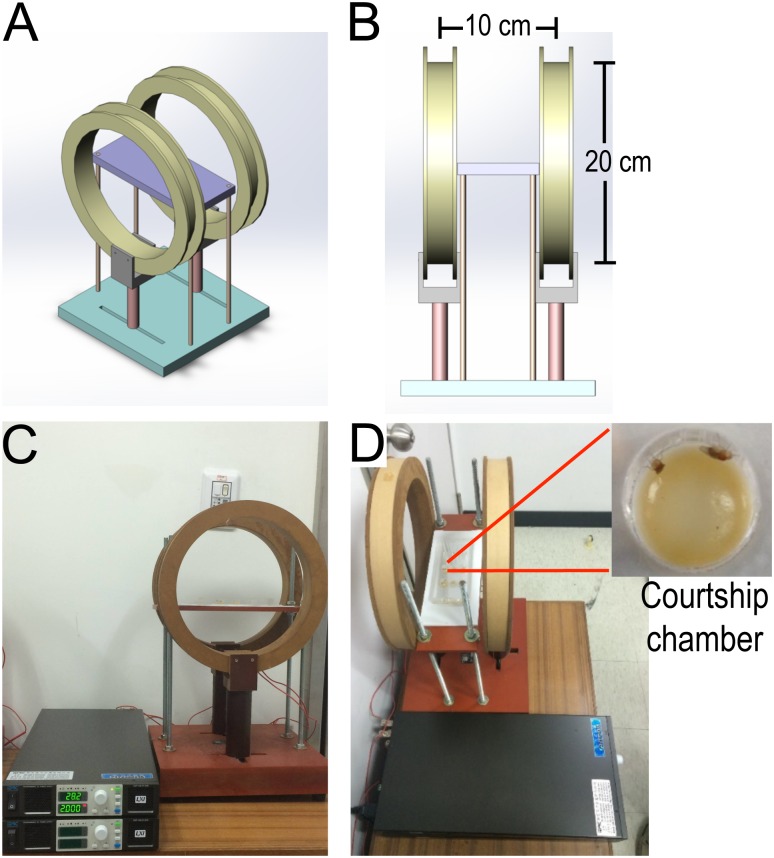
Fly courtship behavioral assay on a Helmholtz coil platform.(A-B) Diagrams of the Helmholtz coil platform. (C) Photograph of the Helmholtz coil platform, which is composed of two Helmholtz coil rings and a DC power supply. (D) The courtship chambers were placed in the middle of the Helmholtz coil platform, and a video camera on the top of the platform was used to record the fly courtship behaviors.